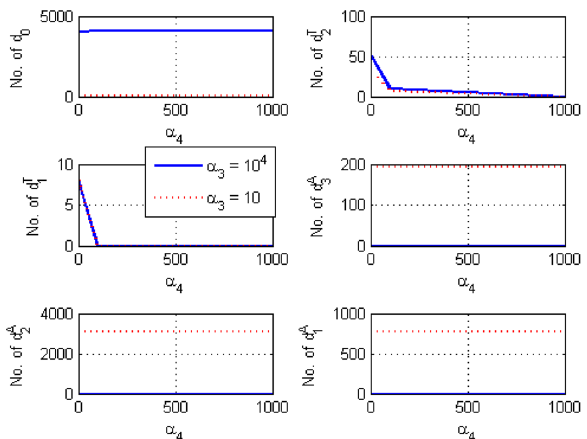
Fig. 10 Trends in optimal policy with respect to 𝛼 4 . Specifically, the frequency of each decision, e.g., no operation ( d 0 ), treatment cam- paign in network 1 ( d T 1 ), awareness campaign in network 2 ( d A 2 ) etc. is plotted against the ranges of the parameter ( 𝛼 4 ) values. Further- more, the blue graphs correspond to the value 𝛼 4 = 10 4 and the doted red graphs correspond to 𝛼 4 =